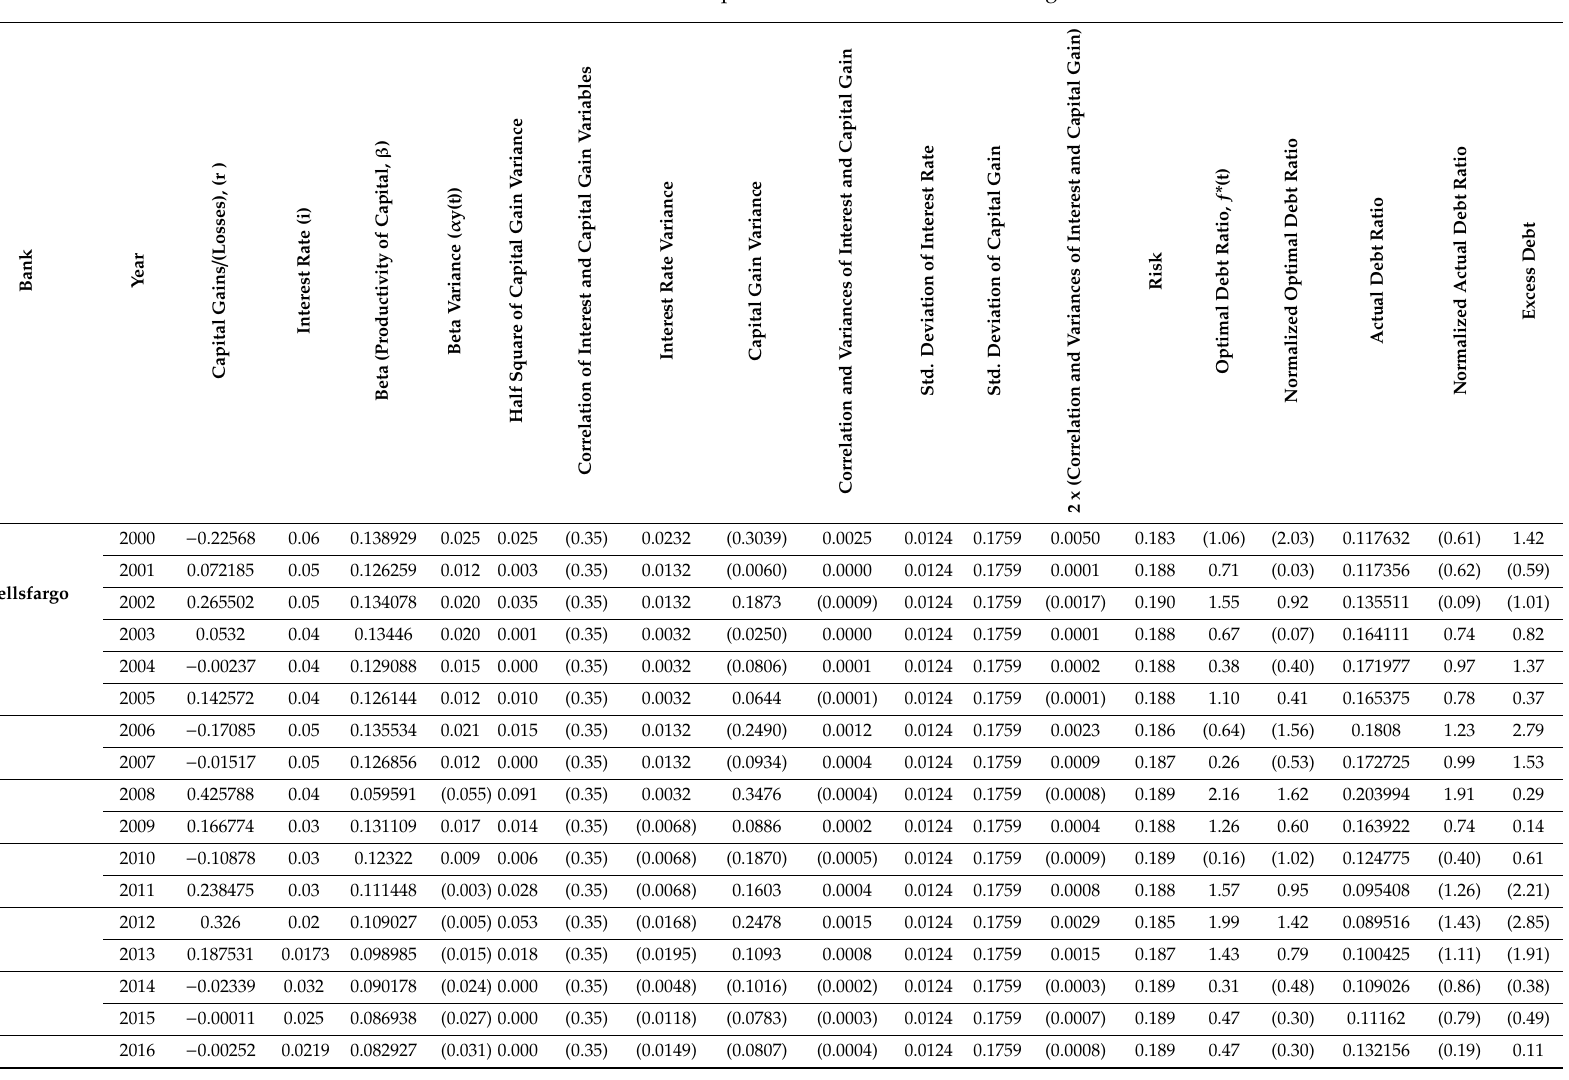
Table A15. Calculations of Optimal and Excess Debt: